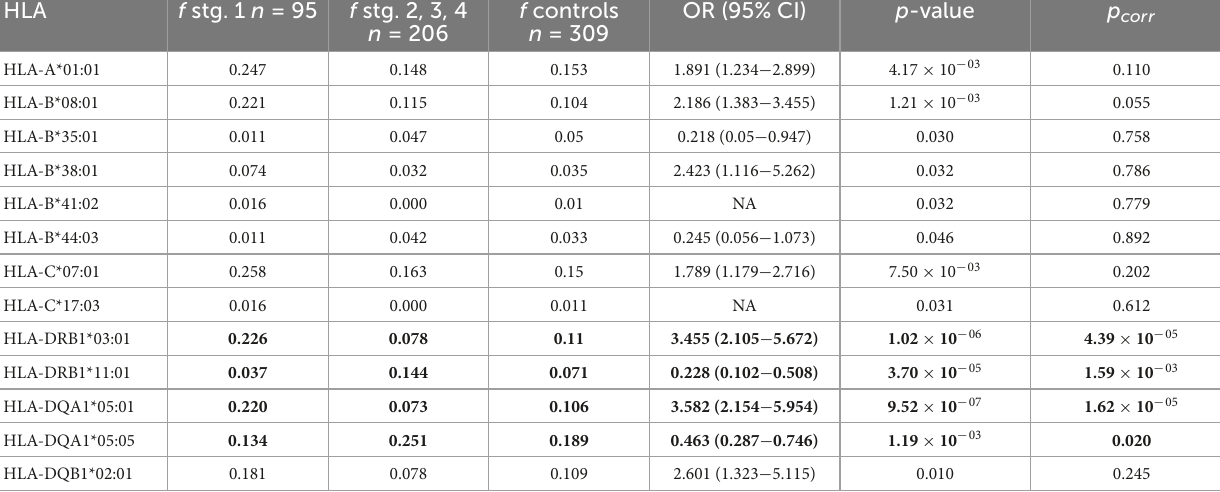
TABLE 4 Comparison of the HLA allele frequencies between the patients with chest X-ray (CXR) stage 1 ( n = 95) compared with the patients with stages 2–4 ( n = 206); only the alleles associated at least on the primary level are shown. HLA f stg. 1 n =